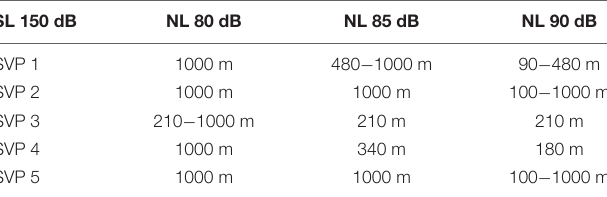
TABLE 3 | Same as Table 2 for 150 dB source level